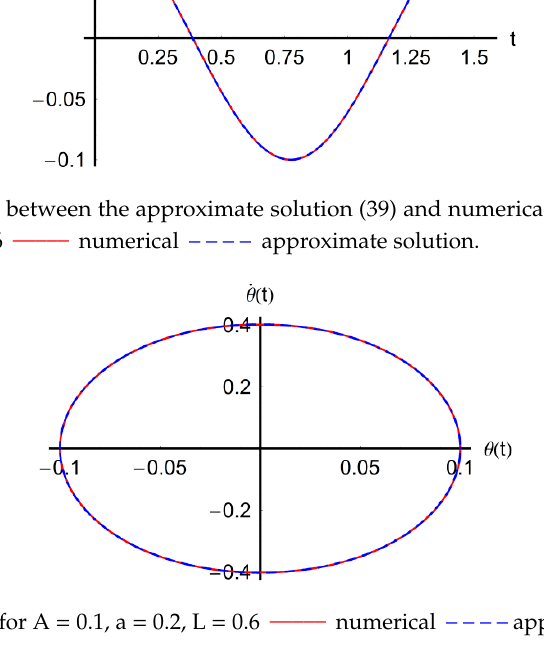
Figure 20. Comparison between the approximate solution (50) and numerical integration results for Figure 21. Phase plane for A = 0.4, L = 0.6.